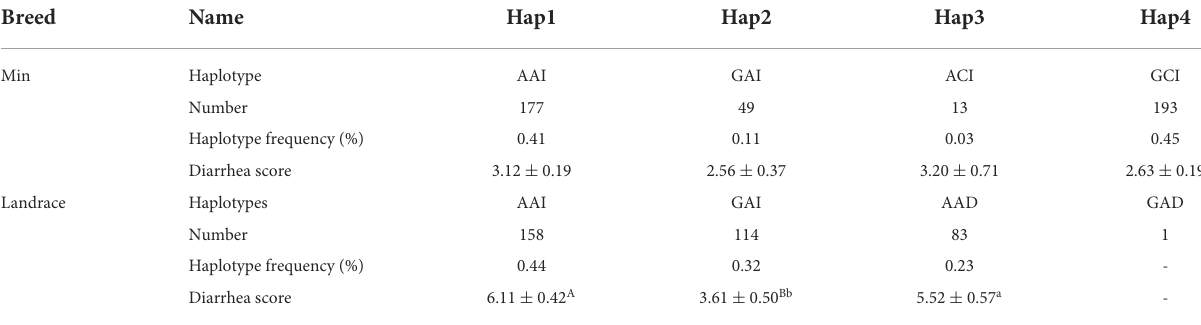
TABLE 3 Haplotype construction among three functional loci of porcine STAT3, haplotype frequency and association analysis in Min and Landrace population. Breed